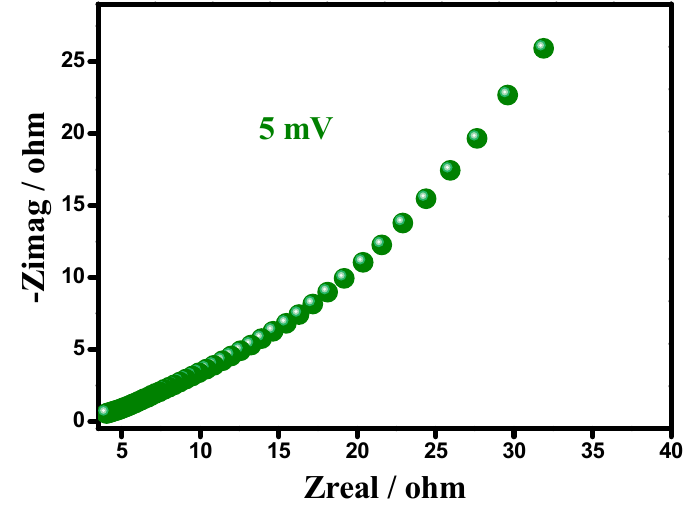
Figure 13. Nyquist plot of symmetric supercapacitor device.